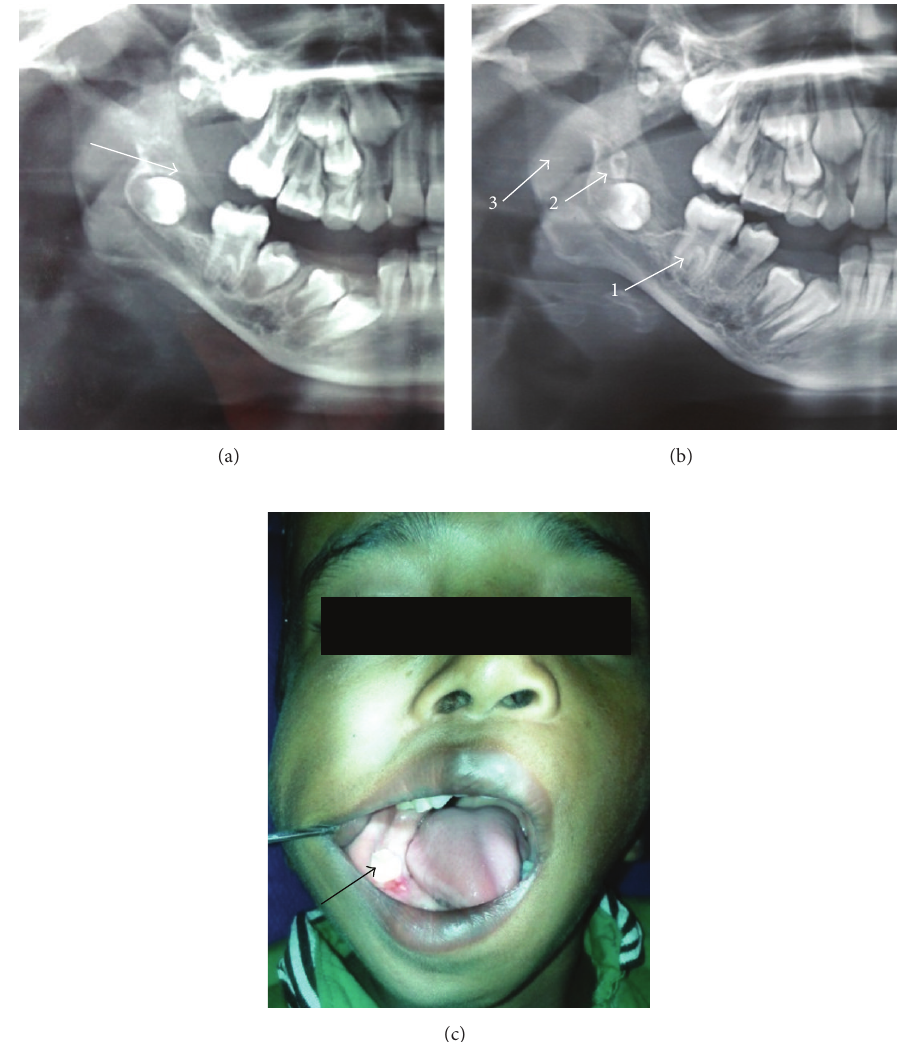
Figure 3: (a) One-year follow-up OPG shows reduced tumor size (arrow), (b) OPG after 1 year and 8 months shows erupted first molar (1), appearance of follicle of third molar (2) and presence of residual tumor (3), and (c) intraoral view after 1 year and 8 months shows fully erupted first molar